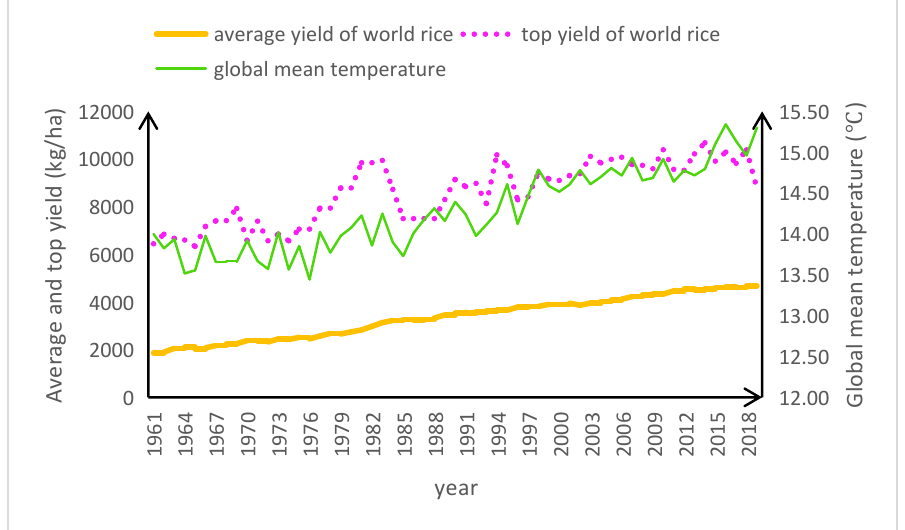
Figure 1. Global mean temperature (°C), average and top yields (kg/ha) of world rice from 1961 to